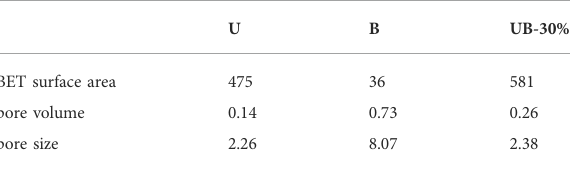
TABLE 1 The BET surface area (m 2 /g), pore volumes (cm 3 /g)and pore sizes (nm) of U, B and UB-30%. U B UB-30% BET surface area